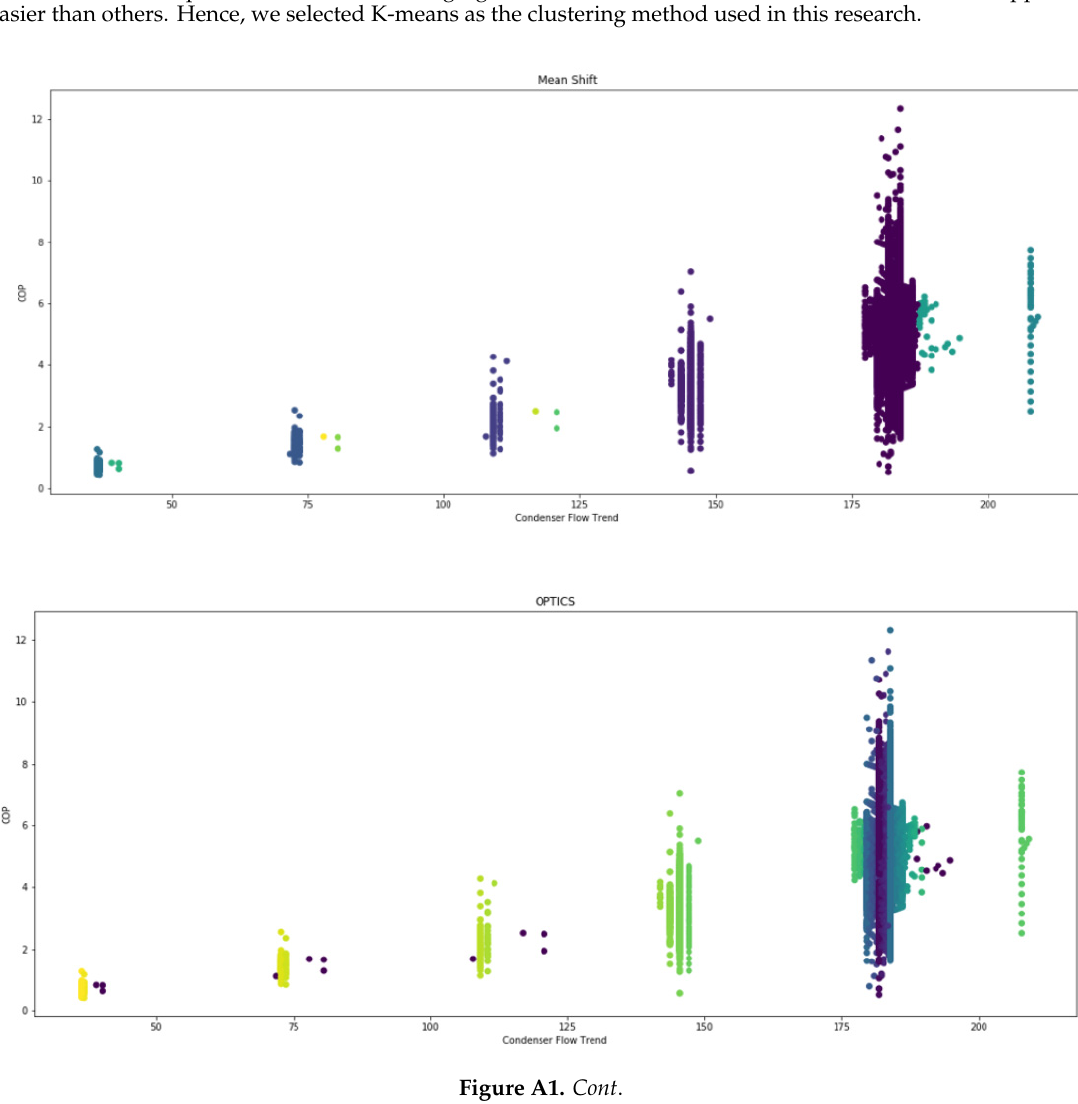
Table A1. Detailed information of each clustering methods.